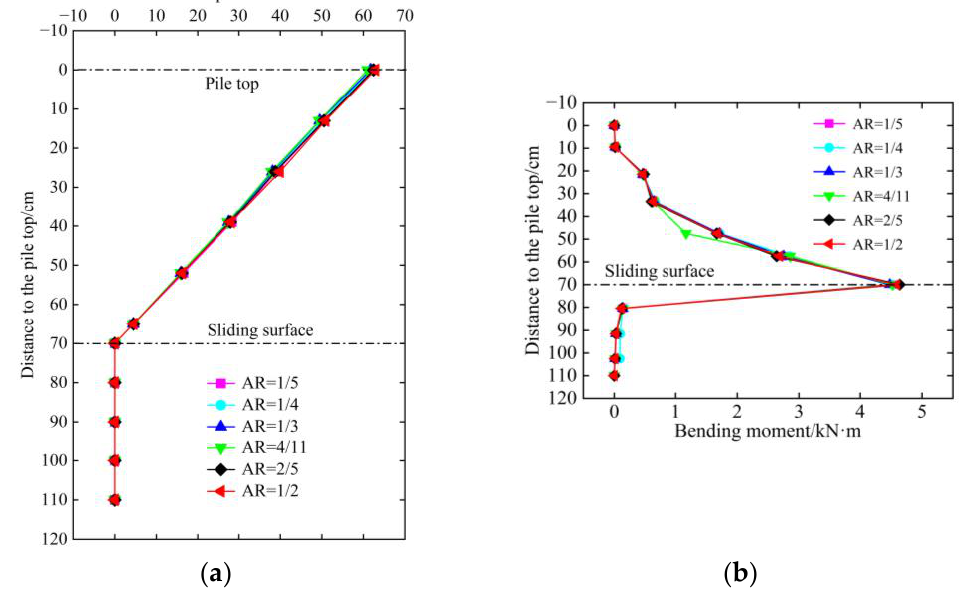
Figure 26. Variations of the pile displacement and bending moment with respect to anchor ratio. ( a ) Pile displacement; ( b ) pile bending moment.